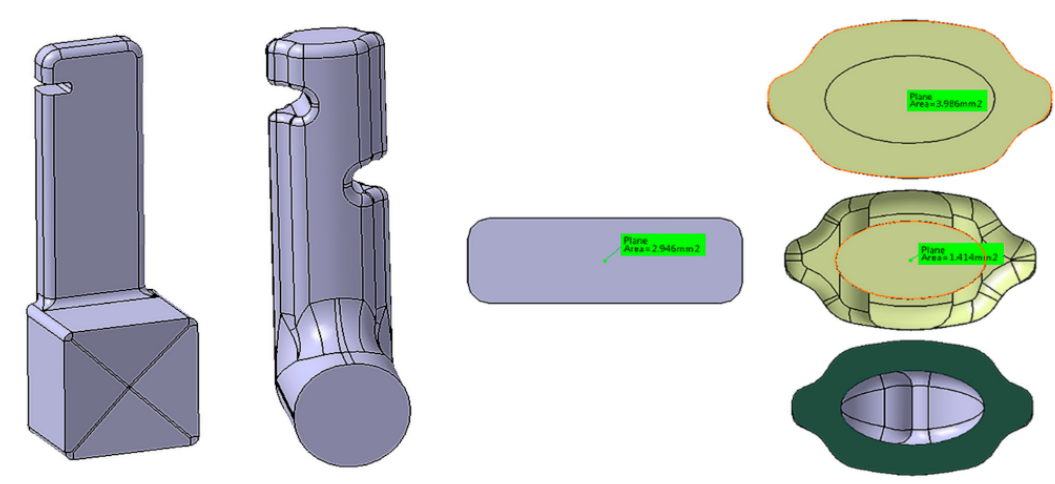
Figure 11. Power-arm designs: Variant I on the left (2018) and variant II (2021) next to it. The right side of the figure shows cross-sectional area of variant II that is smaller by 0.374 mm 2 when compared to the cross-sectional area of variant